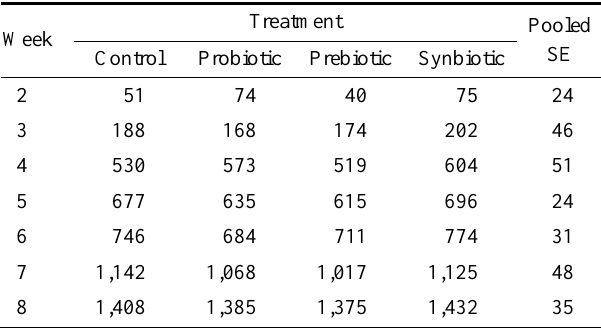
Treatment Pooled